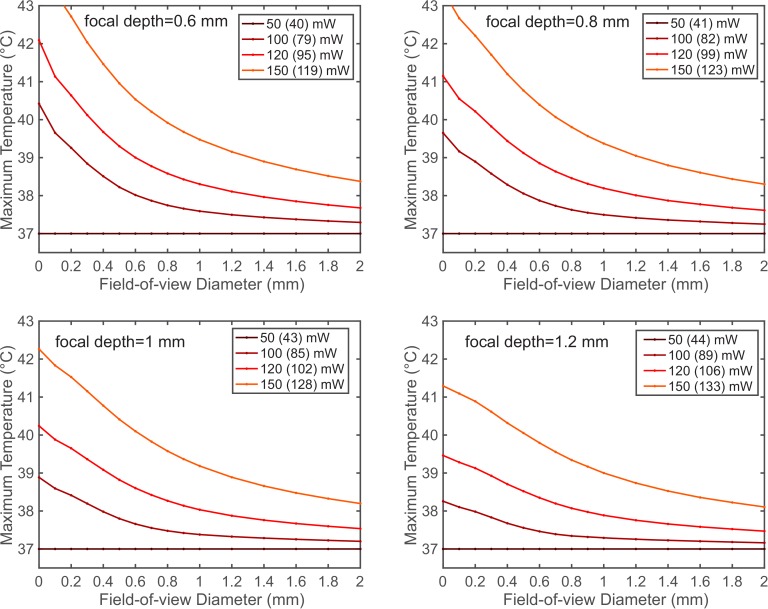
The maximum brain temperature decreases with the scanning field-of-view.The simulation was performed for 1320 nm excitation wavelength at 1- and 1.2 mm imaging depth with various average powers after the objective lens. The NA and the back-aperture beam size remain the same as in Figure 3A. Each legend key indicates the power immediately after the objective lens, followed by the power at the brain surface after immersion water absorption (in the bracket).